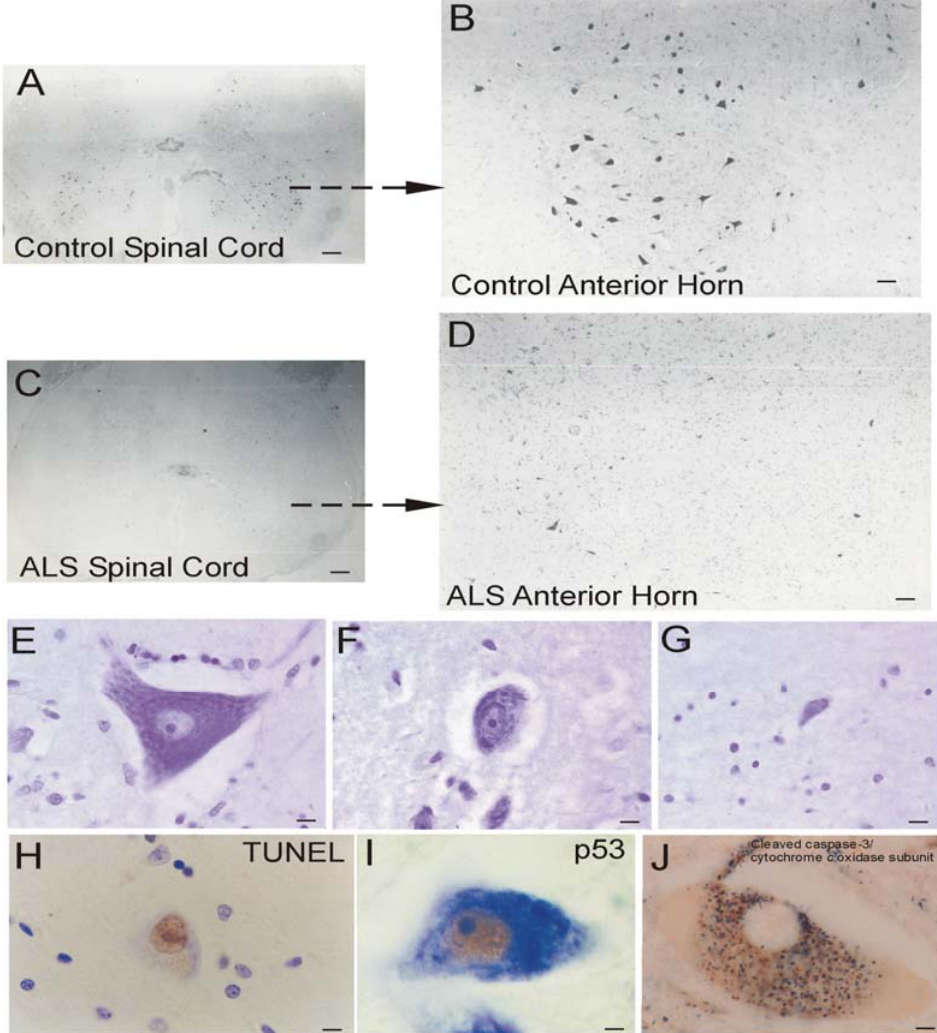
Figure 5. Motor neurons in spinal cord degenerate in people with ALS. A, B . In normal individuals, the spinal cord contains many large, multipolar motor neurons (dark cells). C, D . In ALS, the anterior horn is depleted of large neurons (dark cells) and remaining neurons are atrophic. E-G. Nissl staining shows motor neurons that appear normal (E), attritional (F), and residual (G). H. ALS motor neurons accumulate DNA double-strand breaks in the nucleus (brown labeling). I. p53 (brown labeling) accumulates in the nucleus of motor neurons. J. ALS motor neurons are immunopositive for cleaved caspase-3 (black- dark green labeling), and discrete mitochondria (brown-orange labeling, detected with antibody to cytochrome c oxidase subunit I) accumulate around the nucleus (pale circle). Scale bars: A, 500 μ m (same for C); B, 76 μ m (same for D); E, 6 μ m (same for F,G); H, 12 μ m (same for